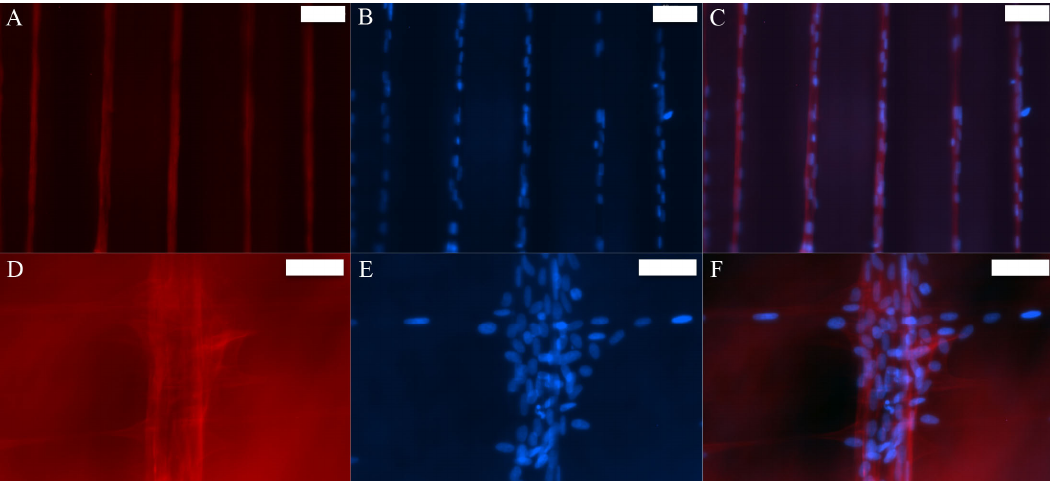
Figure 5. MSCs cytoskeleton and nuclei morphology on aligned scaffolds. Fluorescent microscopy images of equine bone marrow MSCs on an aligned parallel scaffolds ( A – C ) and an aligned perpendicular scaffolds ( D – F ) stained with rhodamine phalloidin ( A , D ); DAPI ( B , E ); and the merged image ( C , F ) on day 12 of cell culture. Scale bar 40 μ m.